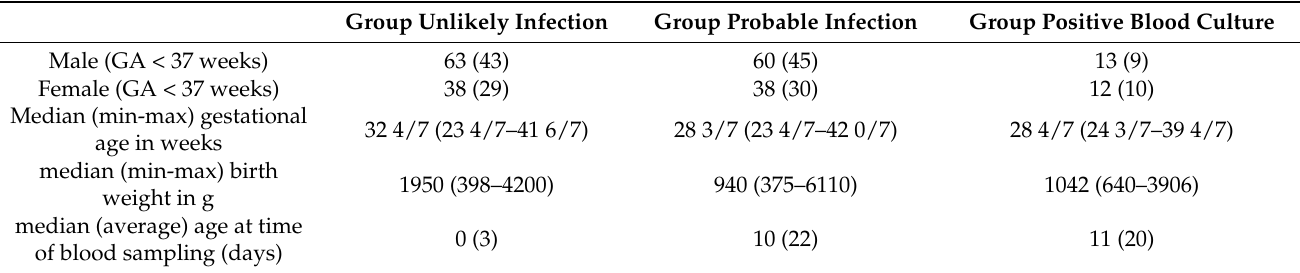
Table 1. Demographic characteristics of the study groups (GA = gestational age). Group Unlikely Infection Group Probable Infection